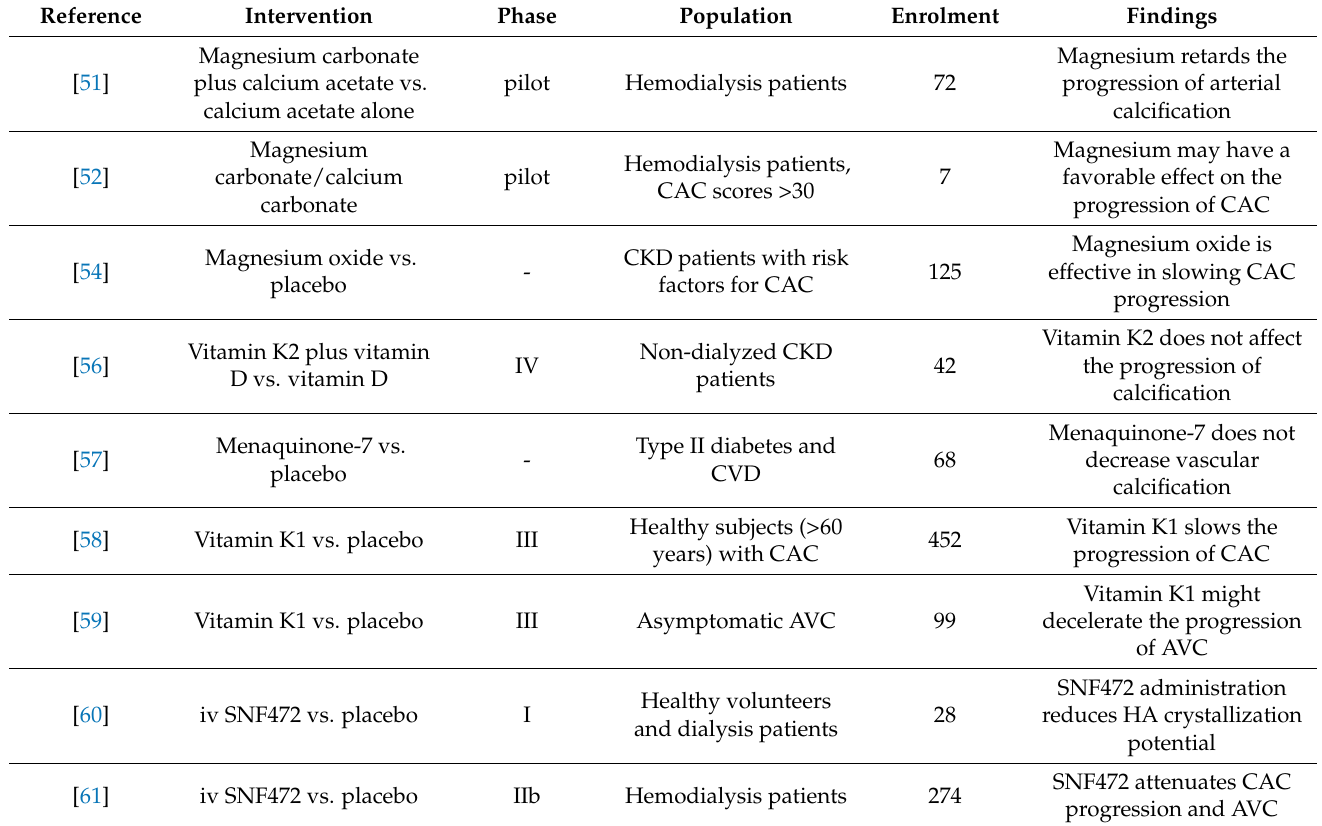
Table 1. Interventional trials performed to evaluate the effects of nutraceuticals on vascular calcification.